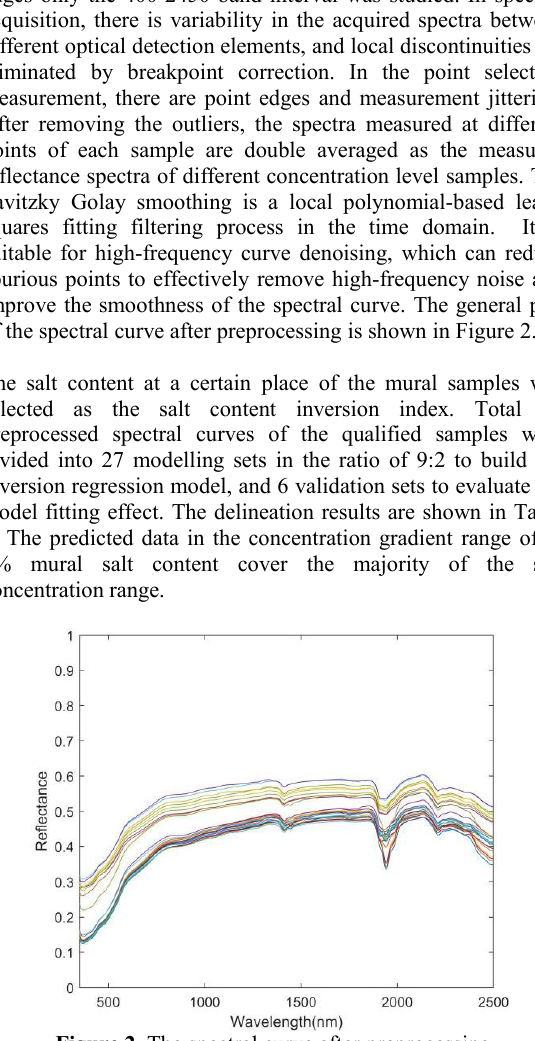
Figure 2. The spectral curve after